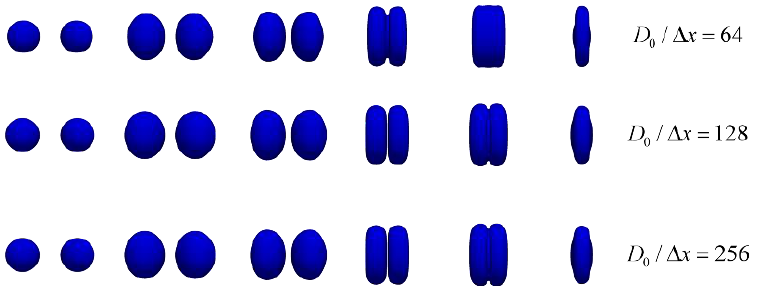
ff erent grid resolutions.